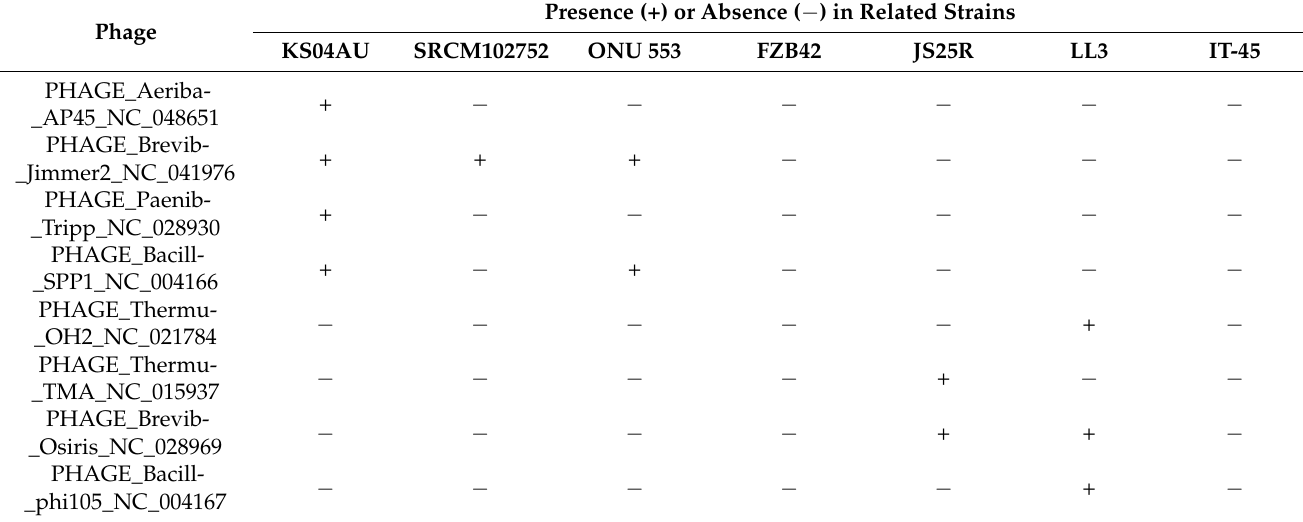
Table 5. Comparison of prophages found in selected